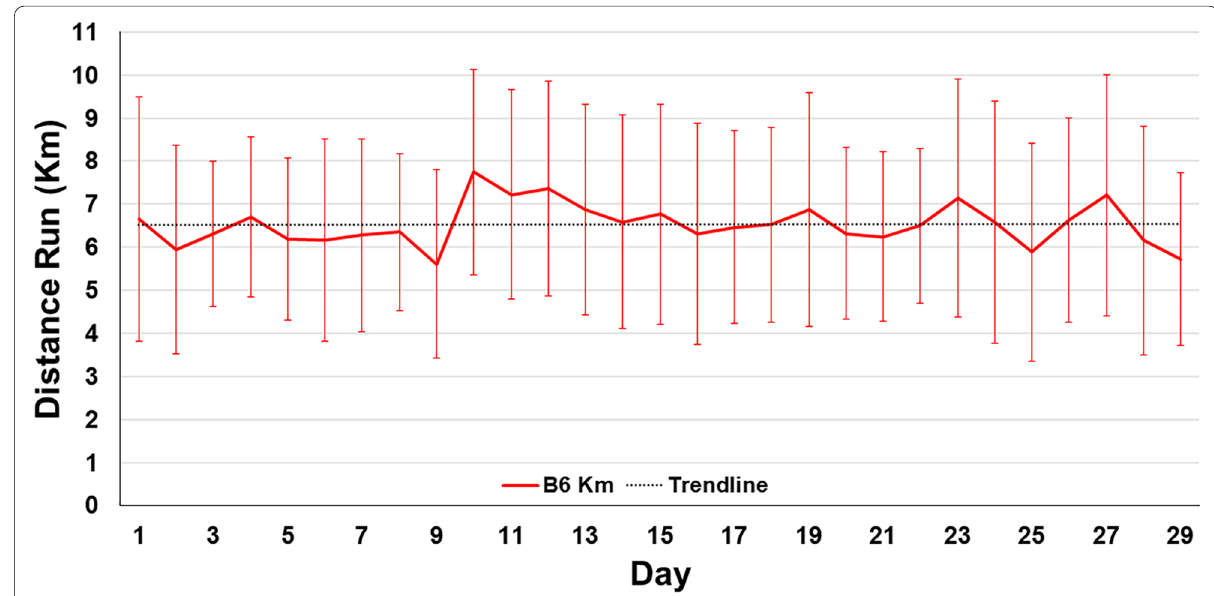
Fig. 3 Daily average and standard deviations of daily kilometers run by all B6 mice in the exercise treatment group